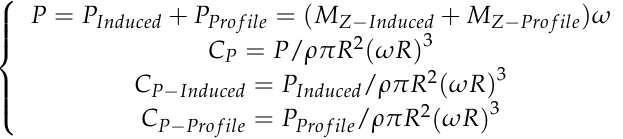
C =0.0091 Test Data W